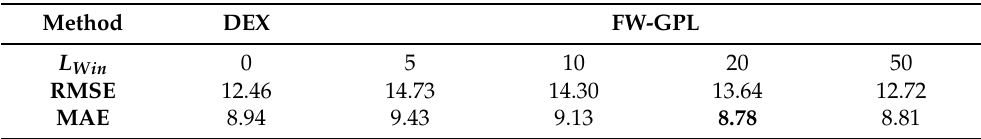
Table 10. Test performance between the DEX and the FW-GPL with fragmentary IMDB-WIKI dataset. (length of output neurons set as 100).